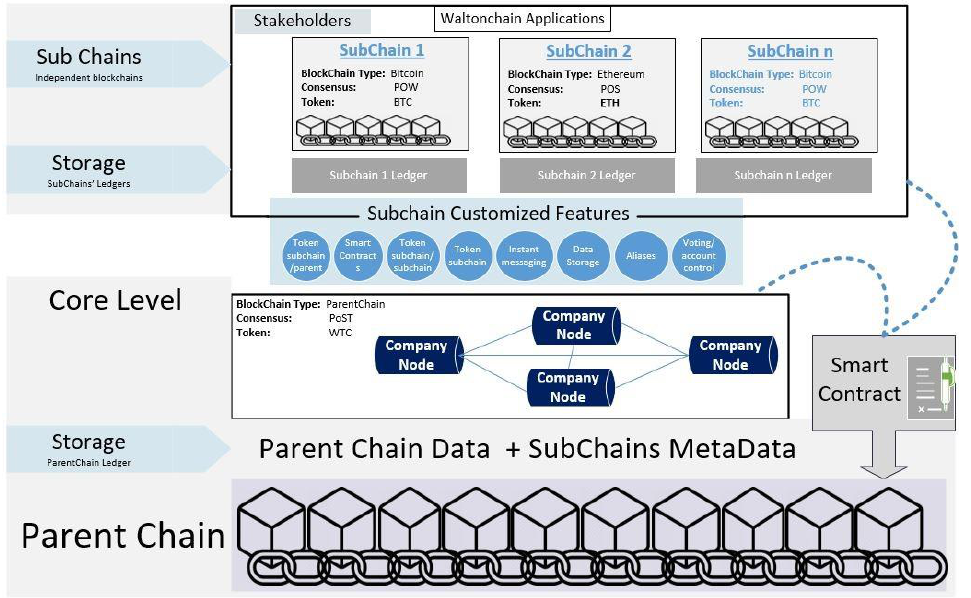
Figure 2. WaltonChain